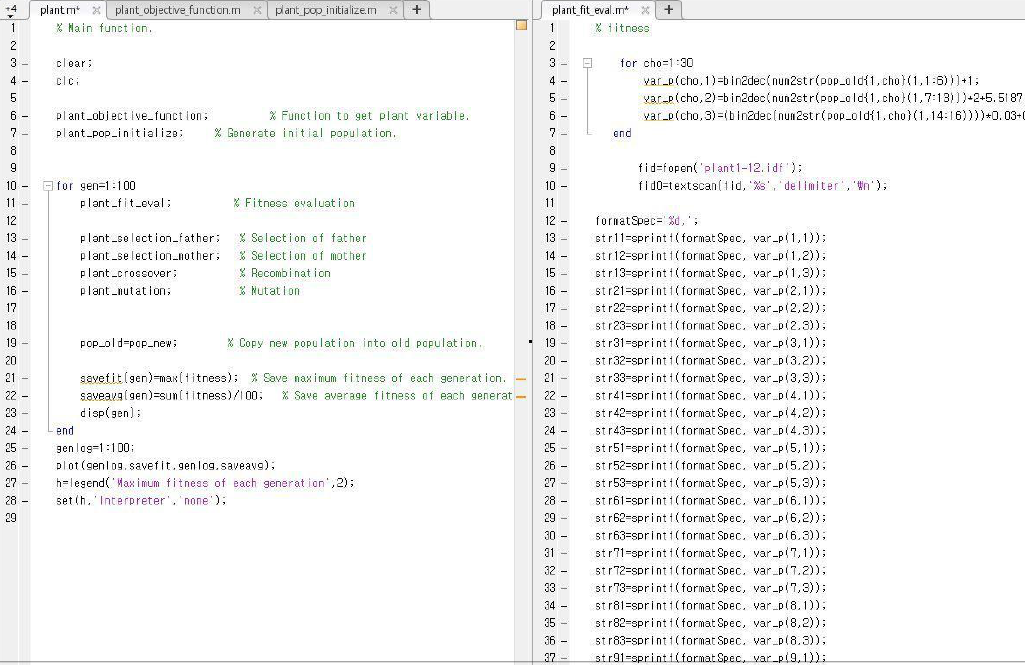
Figure 10. Partial M-Script.